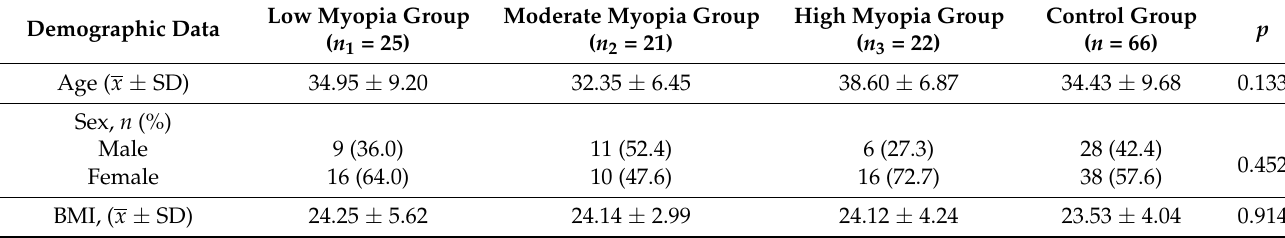
Table 1. Demographic data for study participants.